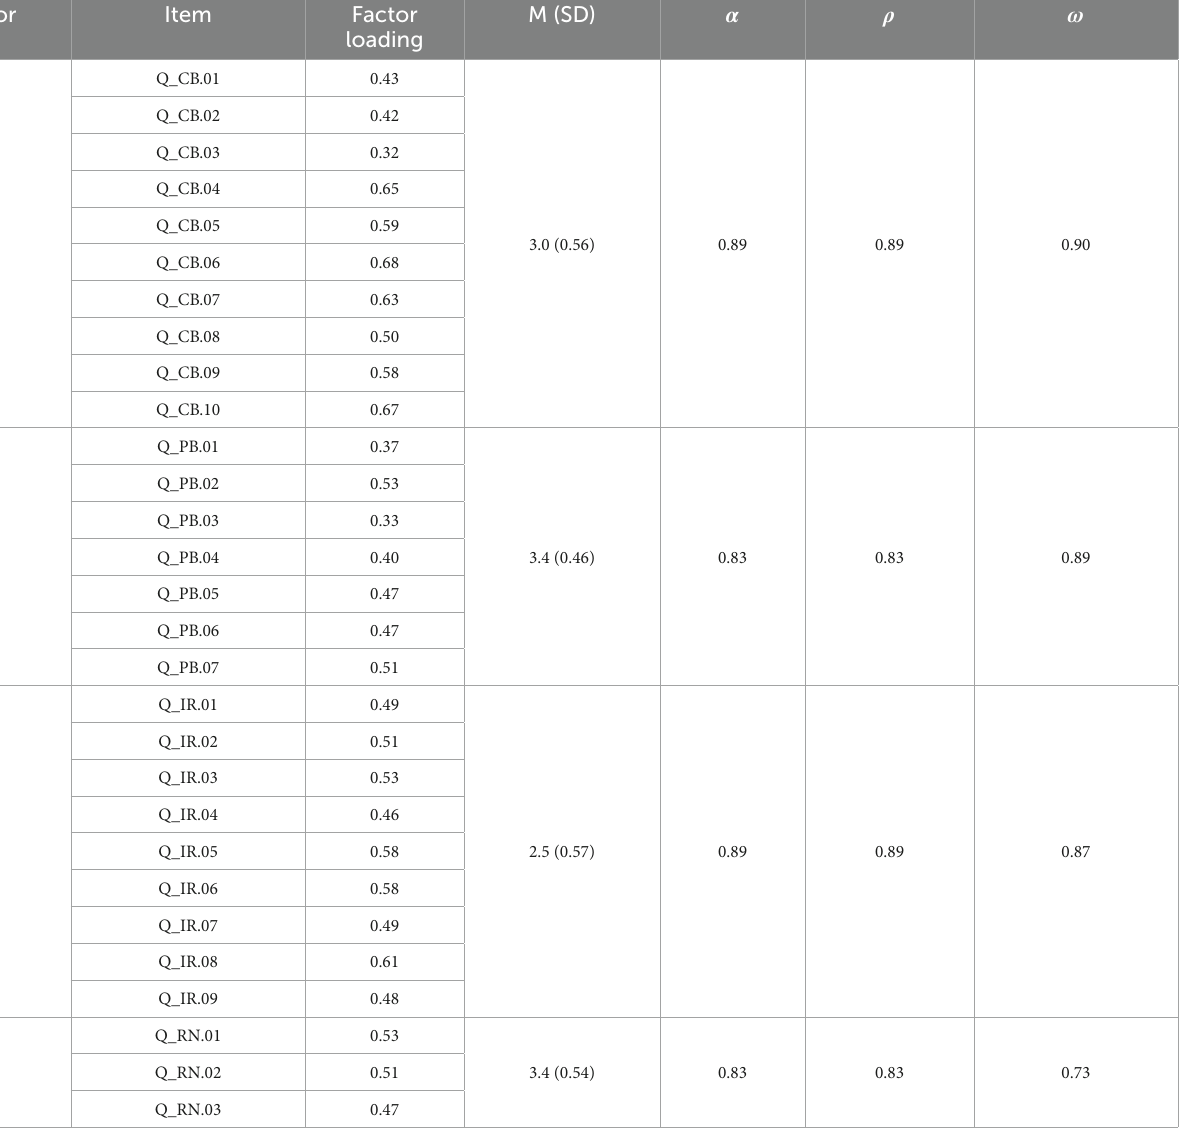
TABLE 2 Reliability indices and factor loadings of the EA-COOPTEC-v0.1 items and subscales. Factor